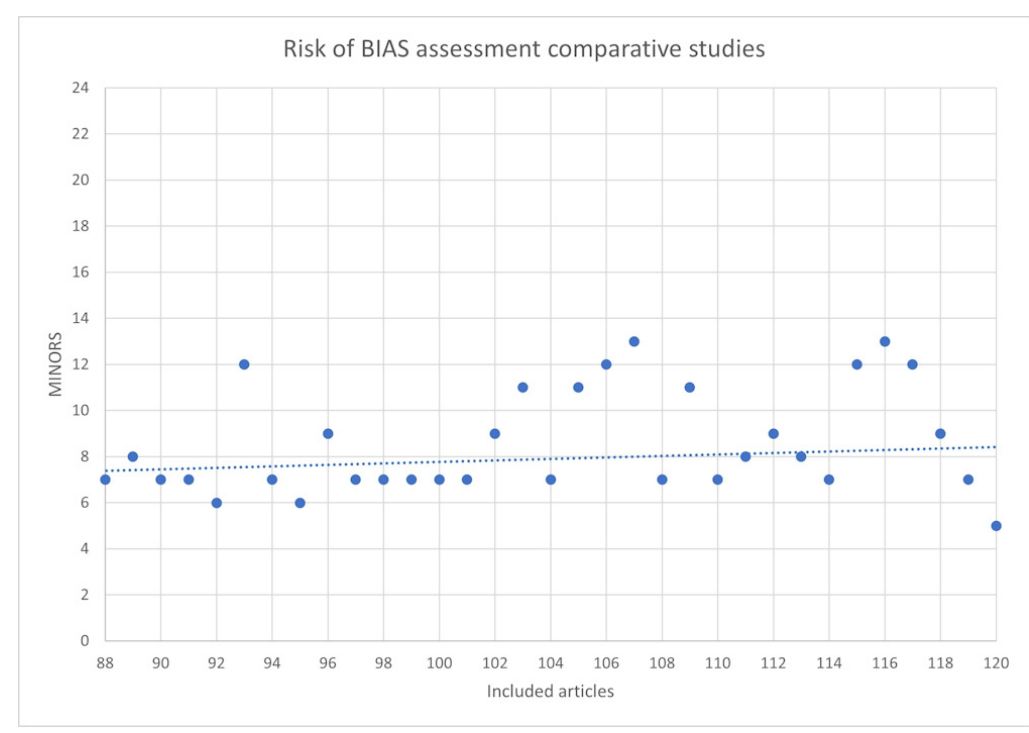
Figure 3. Risk of bias assessment for comparative studies.